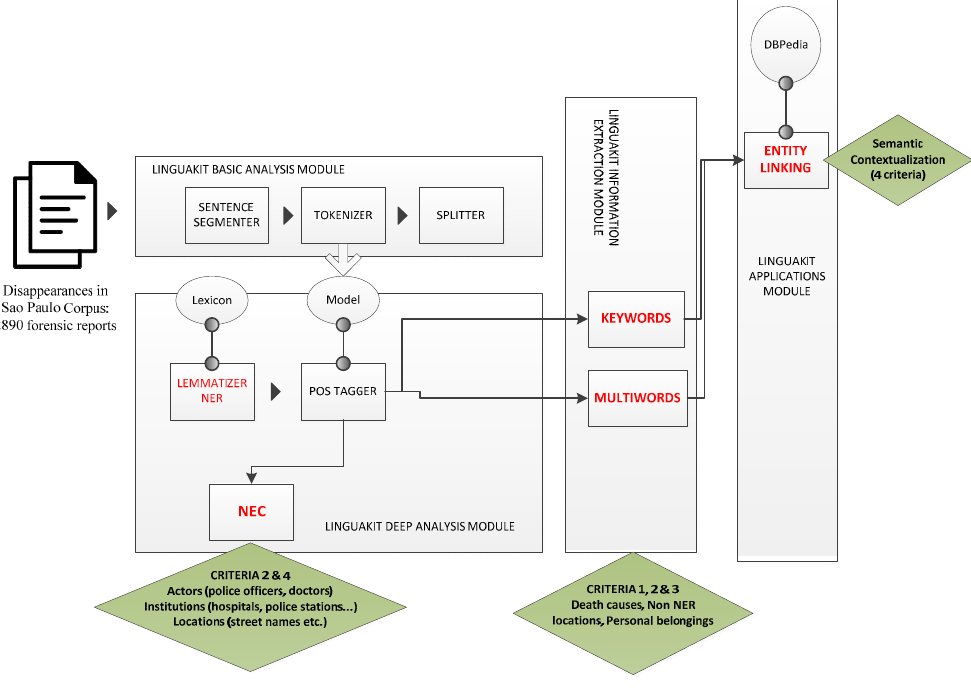
Figure 3. Linguakit modules used for building the natural language processing (NLP) system, and the sequential pipeline and interdependencies between modules output and criteria of analysis taken.